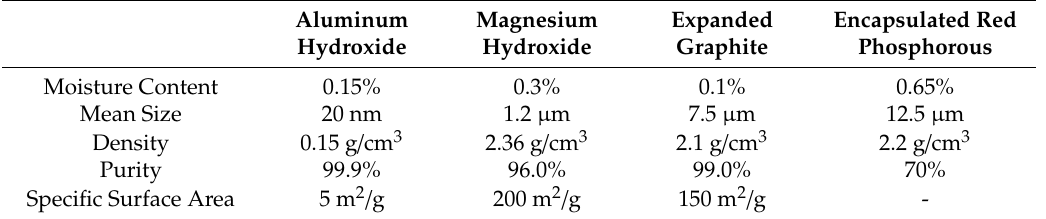
Table 1. Fire retardant